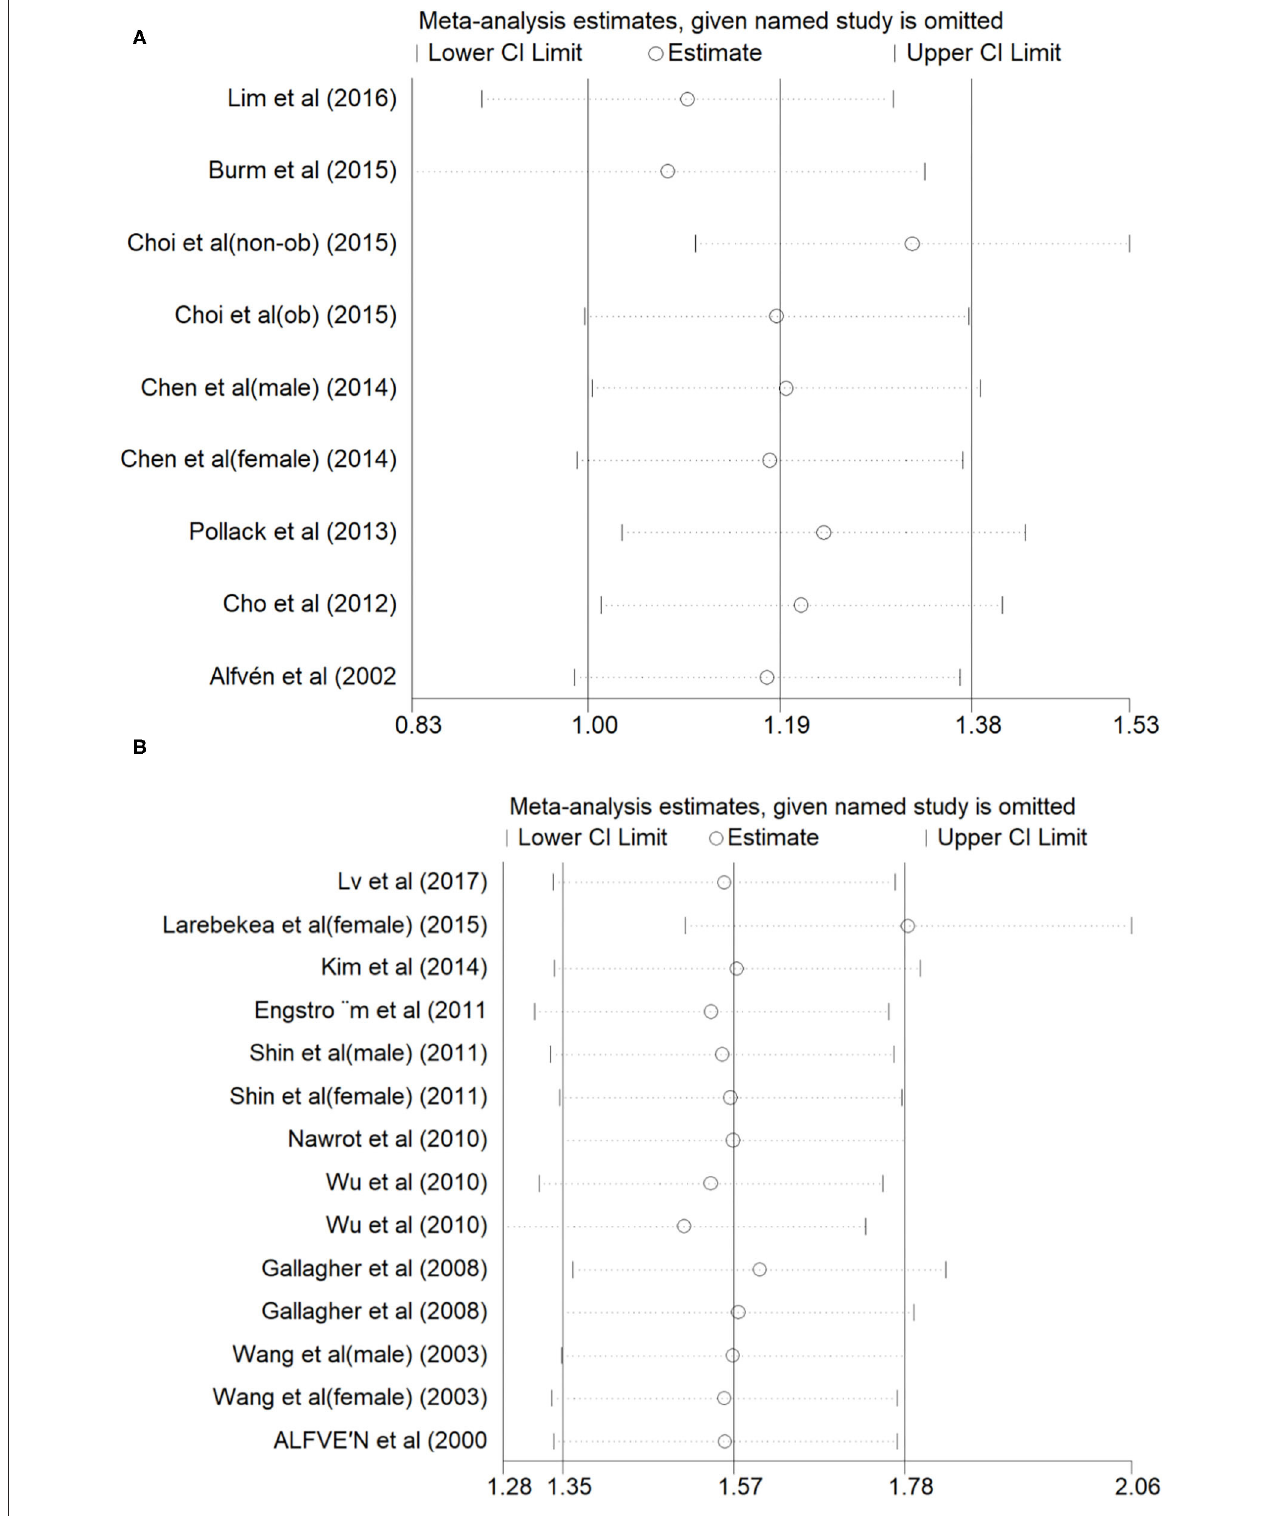
FIGURE 4 | Sensitivity analysis of Blood Cd concentration and osteoporosis or osteopenia (A) , Urinary Cd concentration and osteoporosis or osteopenia (B) .